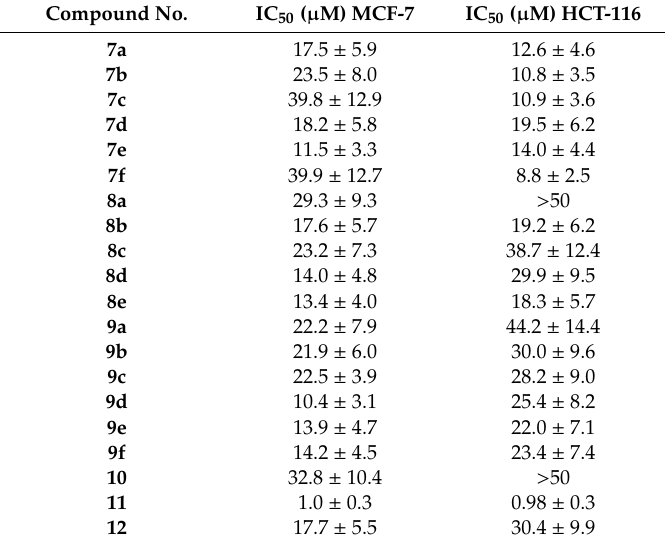
Figure 2. Antiproliferative effect of compound 11 in MCF-7 and HCT-116 cell lines. Cells were grown in 96-well plates and treated with compound 11 at 0.05–100 µM for 72 h. Cell viability was expressed as a percentage of vehicle control [ethanol 0.1% ( v / v )] treated cells. The values represent the mean ± S.E.M. for three independent experiments performed in triplicate. Table 2. Antiproliferative activities of compounds 7a–f , 8a–e , 9a–f , and 10 – 12 in MCF-7 and HCT-116 cell